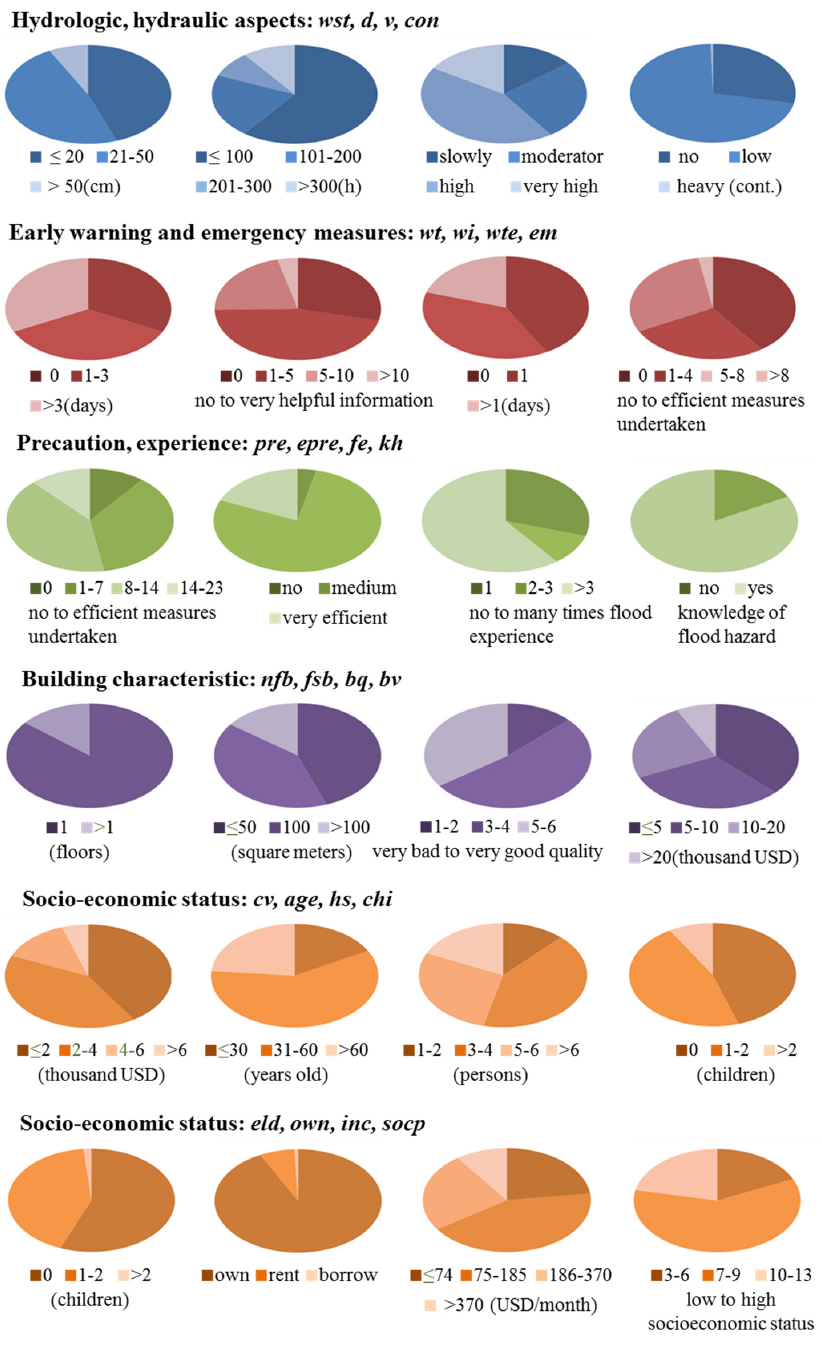
Figure 1. Characteristics of variables by pie diagrams. The colors from dark to light indicate the frequency of the (classified) variable values, in the case of ordinal-scaled variables from small to large